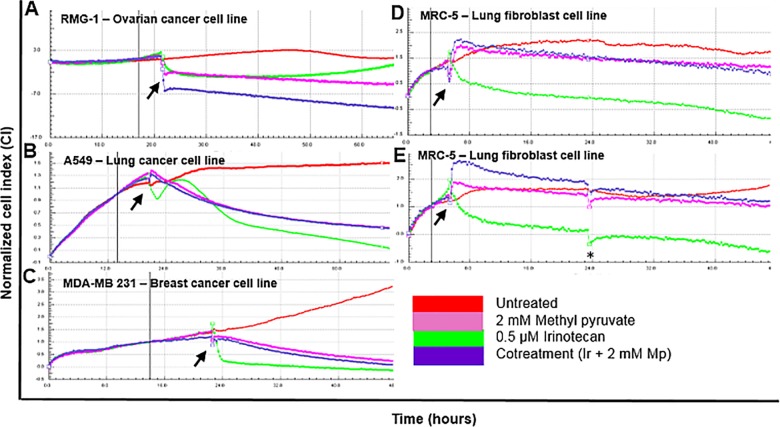
Methyl pyruvate protects normal fibroblast cell line from cell death during treatment with a chemotherapeutic agent.Three cancer cell lines including (a) ovarian cancer (RMG1), (b) lung cancer (A549), (c) breast cancer (MDA-MB 231 and (d) a normal lung fibroblast cell line (MRC-5) were seeded and grown at cell densities of 5 x 103 for RMG-1 cells and 1 x 104 for A549, MDA-MB 231 and MRC-5 until logarithmic phase in 16 well microelectrode E-plates. The cultures were monitored using the xCELLigence Technology. At pre-determined time points permutations of 0.5 μM irinotecan (Ir) and 2 mM methyl pyruvate (Mp) were added to the medium while the cells continued to be monitored by xCELLigence at 37°C. (e) After 20 hours, the medium in MRC-5 cells was replaced with fresh drug-free growth medium and the cells were grown for further 24 hours to assess the effect of methyl pyruvate on recovery from irinotecan treatment. Arrows indicate the pre-determined time points at which drugs were added. These were determined using titration curves to establish optimum cell densities. The Normalized Cell Index (NCIti) was calculated as the cell index (CIti) at a given time point divided by the cell index at the normalized time point (CInml_time) or NCIti = CIti / CInml_time). The normalized time is indicated by the vertical bold line and is for RMG-1 at 17 hours, for A549 and MDA-MB 231 cells at 14 hours and 3 hours for MRC-5 cells. The asterisk indicates replacement of growth medium in the MRC-5 cells culture. Untreated cells were used as controls. The data presented are representative of two independent experiments. A colour code is included. “cotreatment” refers to combination treatment with irinotecan and methyl pyruvate.